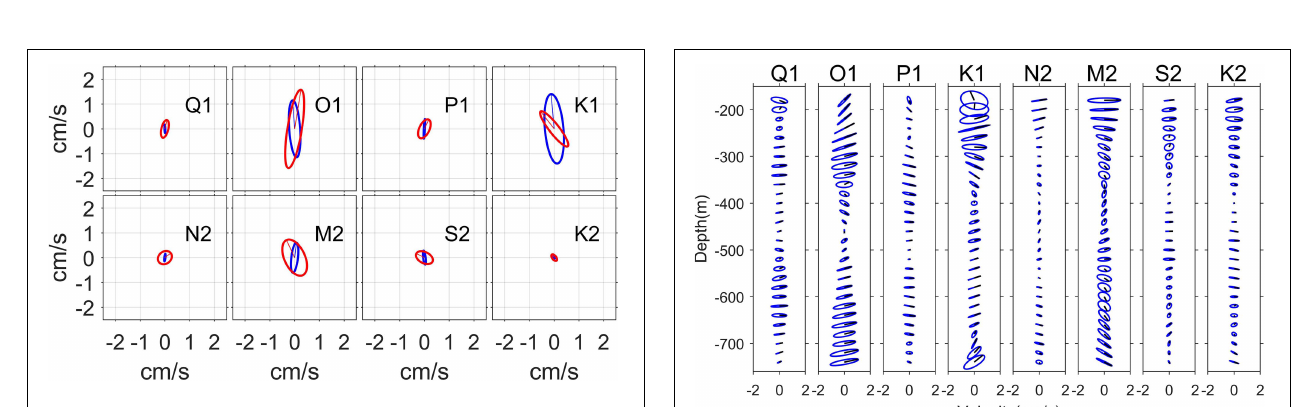
FIGURE 4 | Observed barotropic tidal ellipses (red) and barotropic tidal ellipses predicted from TOXO7.2 (blue).